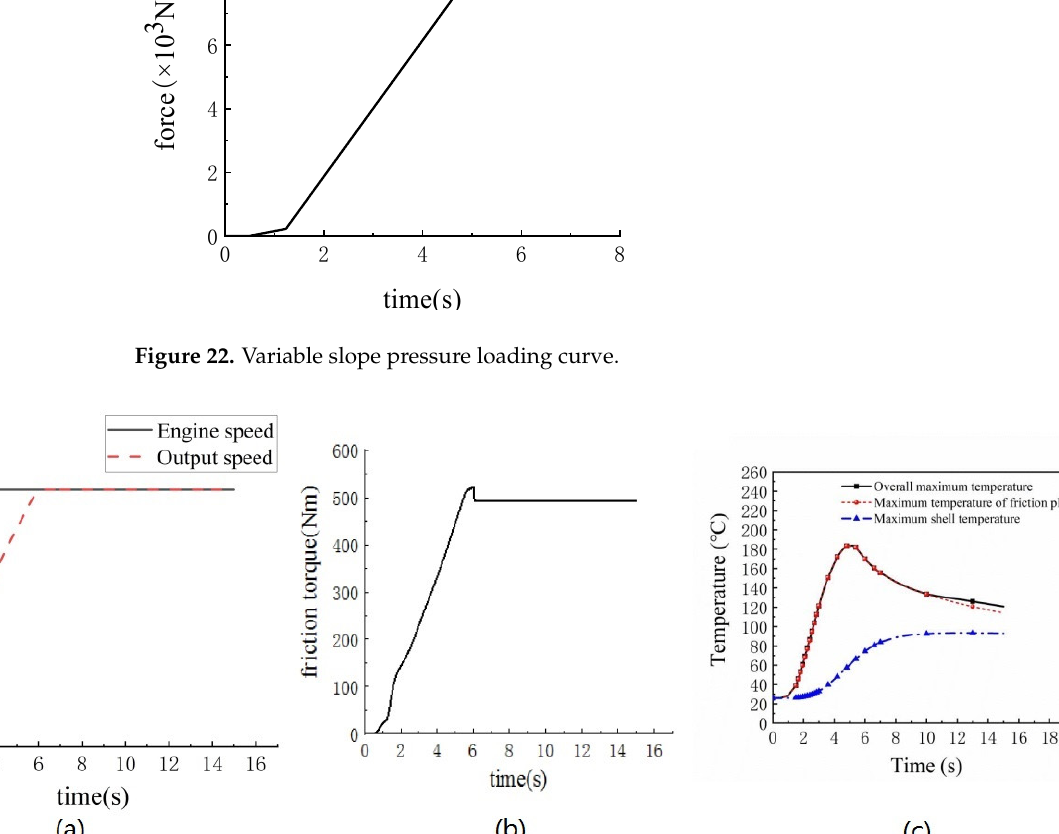
Figure 23. Results of variable slope pressure loading. ( a ) Main/driven disk speed curve ( b ) Torque curve ( c ) Temperature curve. Table 3. Comparison of the simulation results for different loading